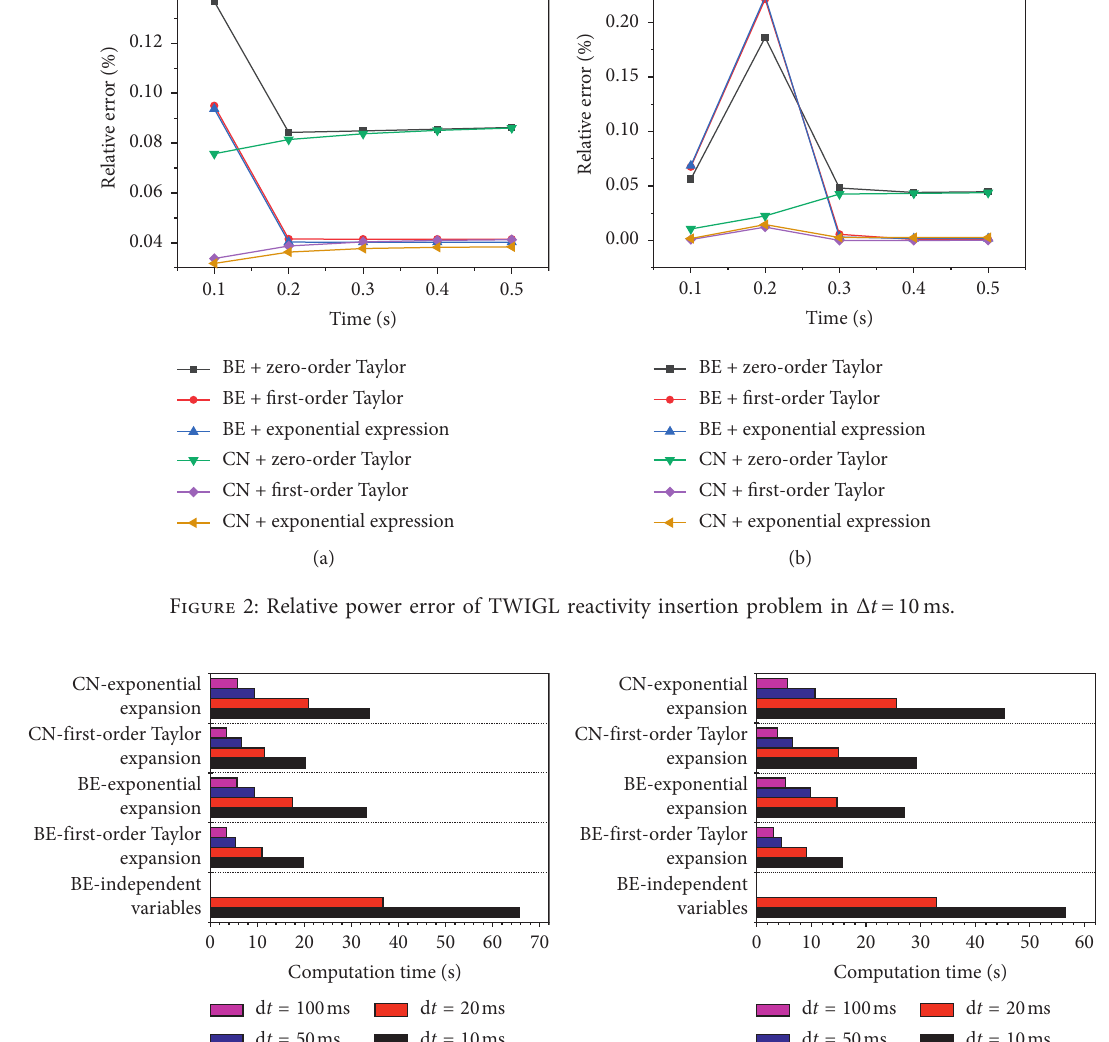
variablesBE-first-order BE-independent